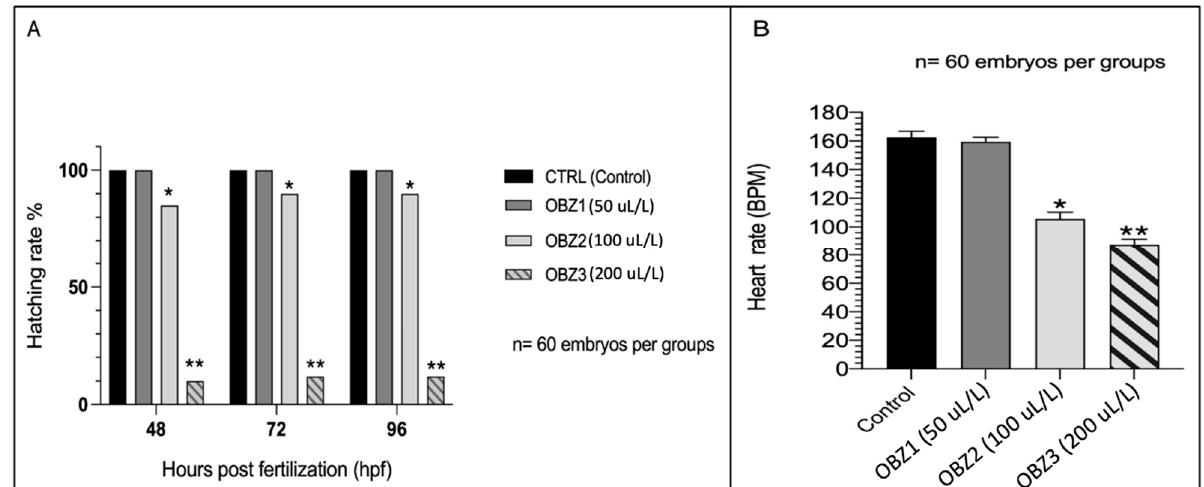
Figure 2. Zebrafish Embryo Toxicity (ZFET) Trial. ( A ) Effect of different concentrations of essential oil on hatching rate. ( B ) Anesthetic effect of basil essential oil on the heart rate at 96 hpf. Significant difference among groups: * OBZ2 vs. CTRL and OBZ1 groups; ** OBZ3 vs. CTRL, OBZ1, and OBZ2 groups. Values are expressed as mean ± SD of three independent experiments. Data are statistically significant for ( p < 0.0001).